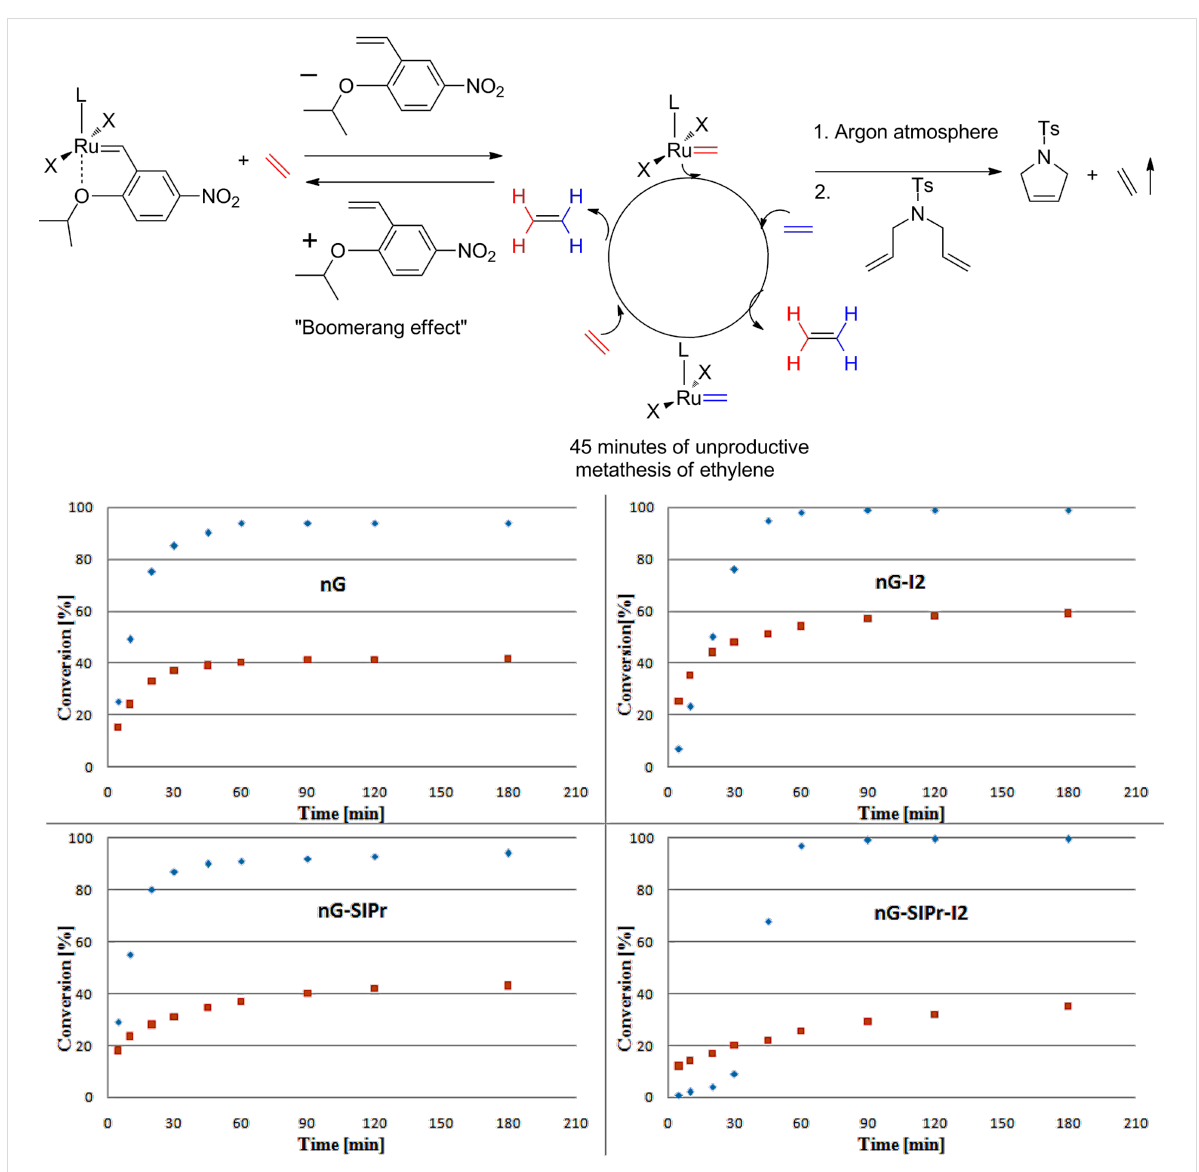
Figure 3: RCM of 1 (toluene, 0.05 M, 25 °C, [Ru] 0.01 mol %); blue diamonds – original (pre)catalysts; red squares – complexes pretreated with ethylene for 45 minutes.